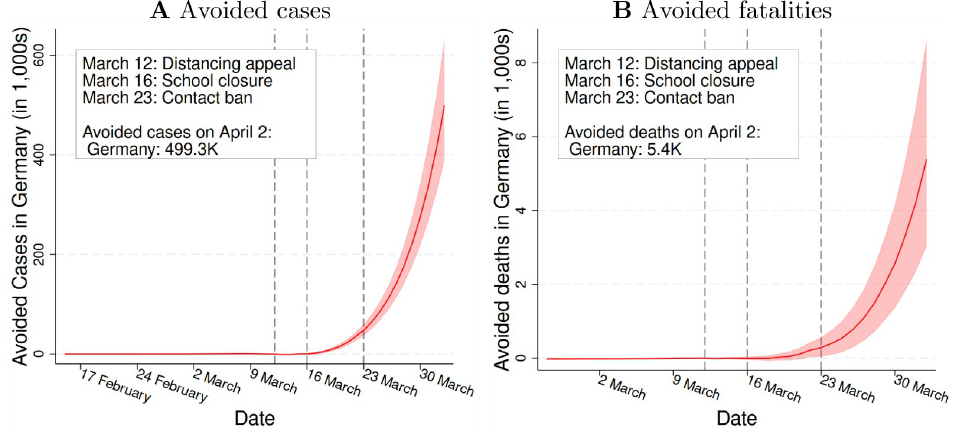
Fig 1. The effectiveness of social distancing policies in Germany. Notes : Fig 1A and 1B summarize the main takeaway message of the paper. Fig 1A depicts our estimates on the number of cases avoided due to social distancing policies. Fig 1B depicts our estimates on the number of fatalities avoided due to these policies. The three vertical lines mark the Chancellor’s appeal for social distancing (March 12), the nationwide school closures (March 16), and the nationwide contact bans (March 23). The dashed lines represent 95% confidence intervals based on district-levelclustered standard